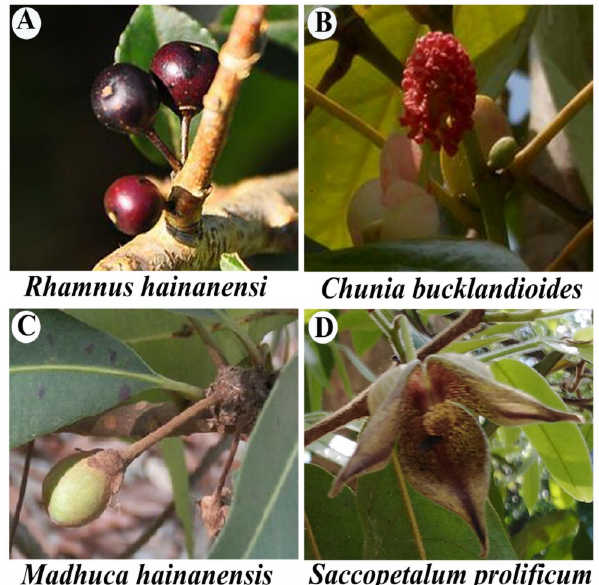
Fig 5. Some representatives of the endemic plant species of Hainan. A, Rhamnus hainanensi Merr. et Chun (Rhamnaceae); B, Chunia bucklandioides H. T. Chang (Hamamelidaceae); C, Madhuca hainanensis Chun et How (Sapotaceae); D, Saccopetalum prolificum (Chun & F. C. How) Tsiang (Annonaceae).